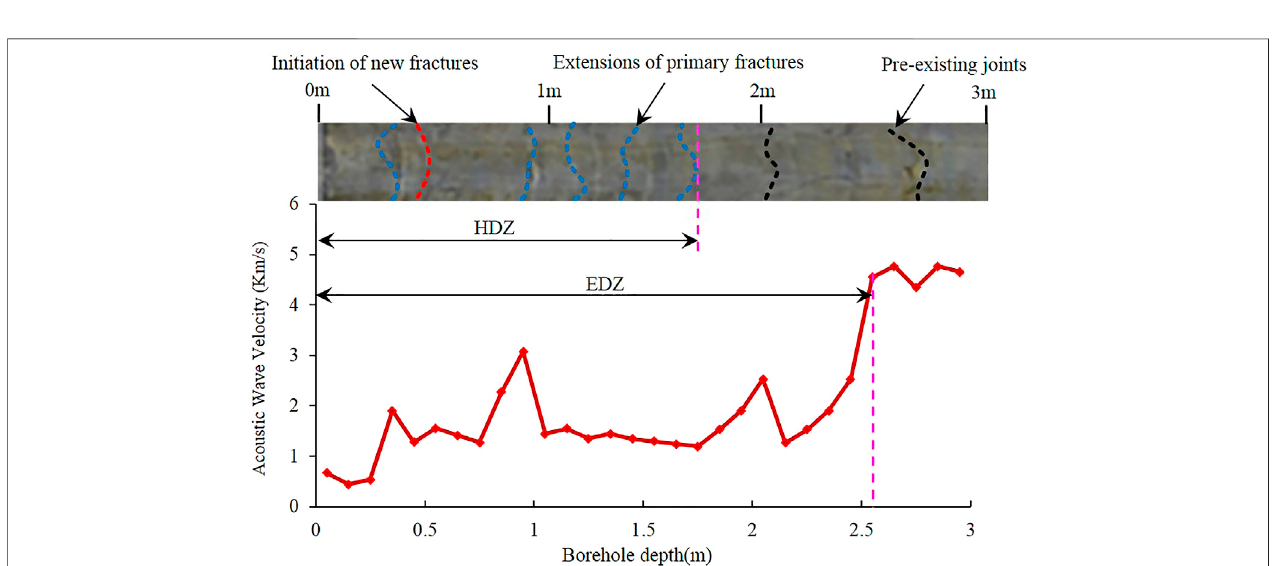
FIGURE 7 | Test result in borehole